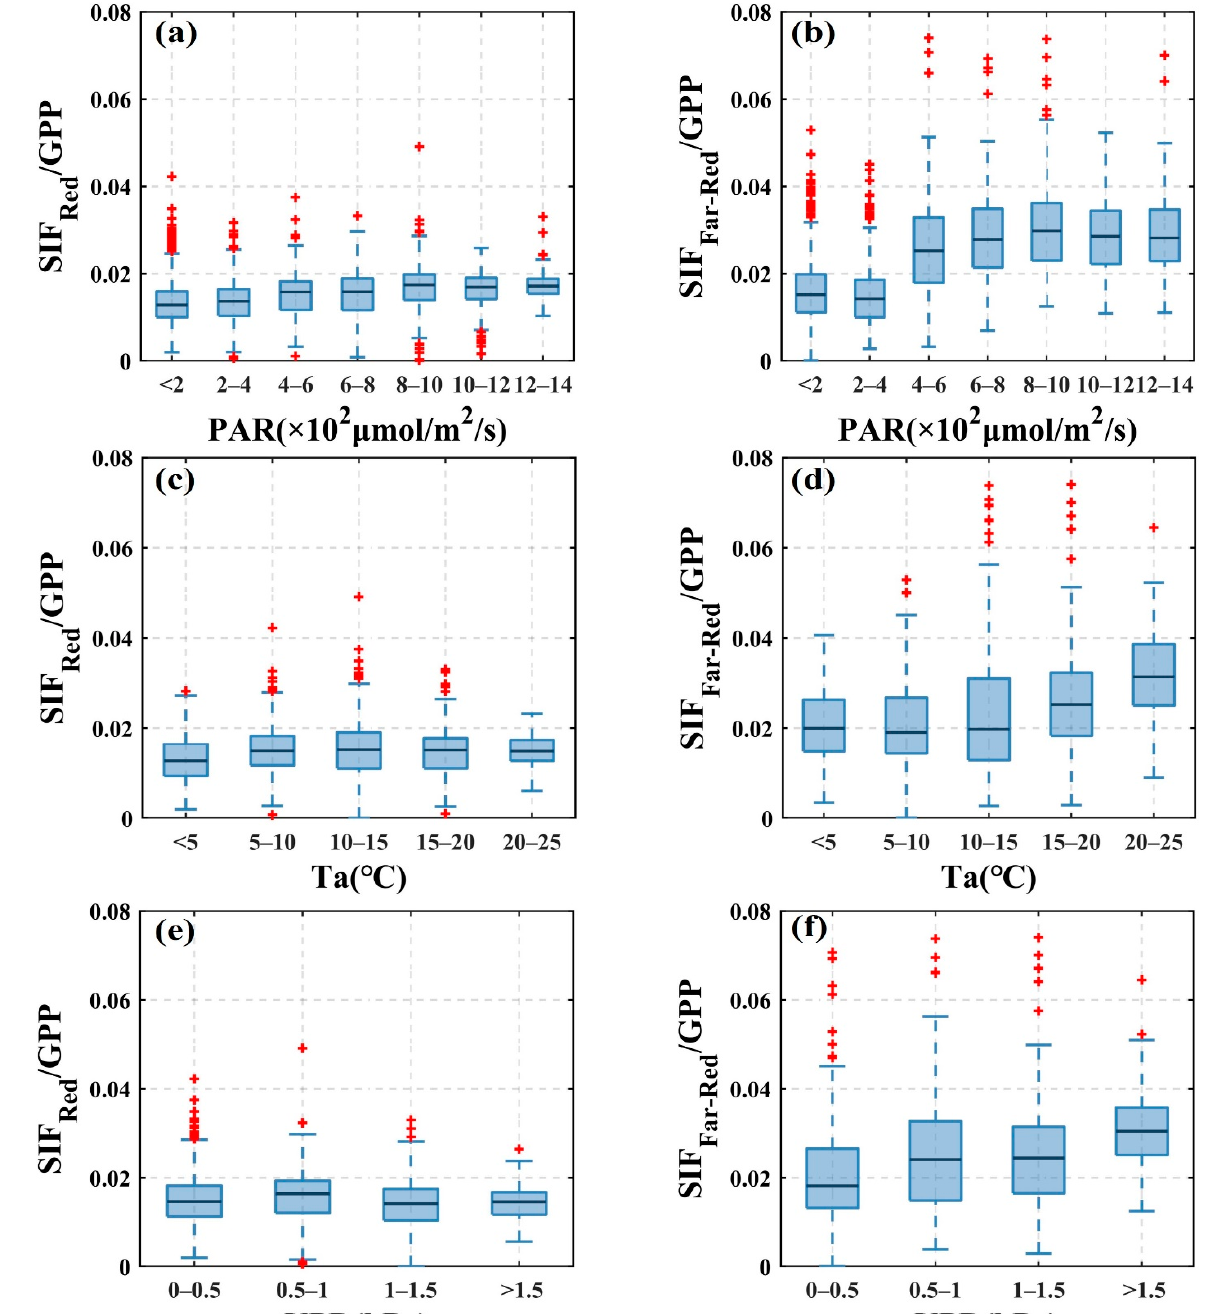
Figure 4. Boxplots show the variation of values of SIF Red /GPP and SIF Far-red /GPP at different levels of environmental factors including ( a , b ) photosynthetically active radiation (PAR), ( c , d ) air temperature (Ta), and ( e , f ) vapor pressure deficit (VPD) at AR site during the 2019 ( left ) and 2020 ( right ) growing seasons with half-hourly averaged data. Red plus signs in the figure represent outliers.